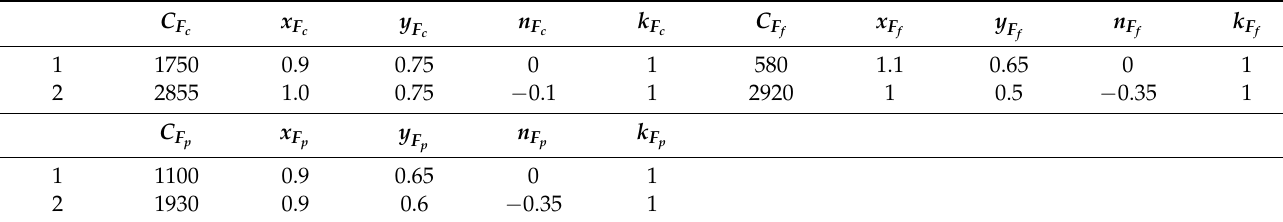
Table 3. Cutting force coefficient.